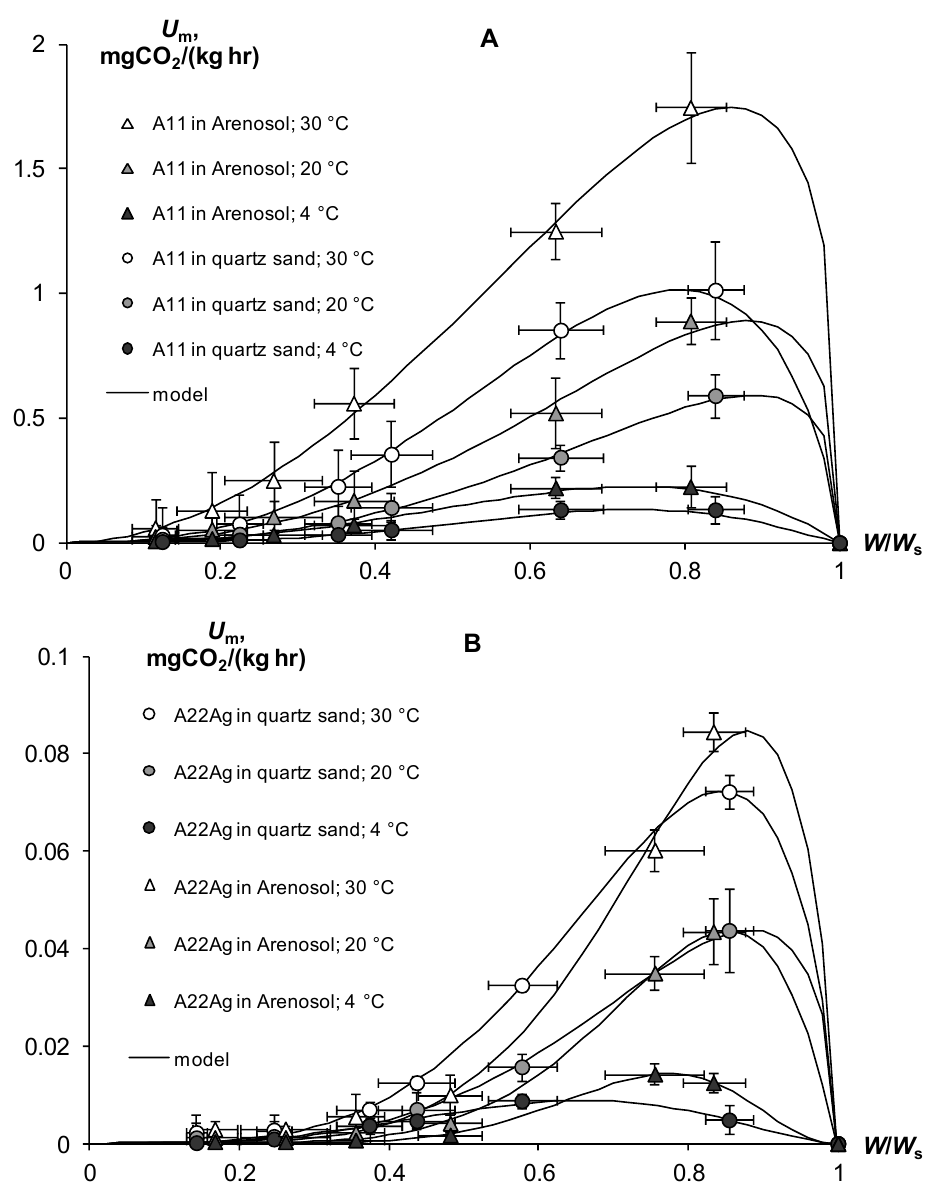
Figure 13. Quantification and modeling of basal respiration of soil-gel compositions ( U m ) as a function of temperature and relative water content ( W/W s ). ( A ) — A11; ( B ) — A22Ag. Model (28) parameters: A11 in Arenosol: 30 °C, f (W) = ( W/W s / 0.86) 2.05 {(1 − W/W s ) / (1 − 0.86)} 0.33 ; R 2 = 0.998, s = 0.02; 20 °C, f (W) = ( W/W s / 0.88) 2.59 {(1 − W/W s ) / (1 − 0.88)} 0.35 ; R 2 = 0.992, s = 0.04; 4 °C, f (W) = ( W/W s / 0.74) 2.84 {(1 − W/W s ) / (1 − 0.74)} 1.00 ; R 2 = 0.992, s = 0.04; A11 in quartz sand: 30 °C, f (W) = ( W/W s / 0.79) 2.77 {(1 − W/W s ) / (1 − 0.79)} 0.72 ; R 2 = 0.997, s = 0.02; 20 °C, f (W) = ( W/W s / 0.89) 2.77 {(1 − W/W s ) / (1 − 0.89)} 0.35 ; R 2 = 0.997, s = 0.02; 4 °C, f (W) = ( W/W s / 0.73) 3.52 {(1 − W/W s ) / (1 − 0.73)} 1.27 ; R 2 = 0.988, s = 0.05; A22Ag in Arenosol: 30 °C, f (W) = ( W/W s / 0.88) 5.30 {(1 − W/W s ) / (1 − 0.88)} 0.72 ; R 2 = 0.993, s = 0.04; 20 °C, f (W) = ( W/W s / 0.85) 6.27 {(1 − W/W s ) / (1 − 0.85)} 1.08 ; R 2 = 0.997, s = 0.02; 4 °C, f (W) = ( W/W s / 0.77) 8.69 {(1 − W/W s ) / (1 − 0.77)} 2.54 ; R 2 = 0.998, s = 0.02; A22Ag in quartz sand: 30 °C, f (W) = ( W/W s / 0.75) 4.04 {(1 − W/W s ) / (1 − 0.75)} 0.73 ; R 2 = 0.999, s = 0.01; 20 °C, f (W) = ( W/W s / 0.88) 3.86 {(1 − W/W s ) / (1 − 0.88)} 0.51 ; R 2 = 0.998, s = 0.02; 4 °C, f (W) = ( W/W s / 0.66) 3.54 {(1 − W/W s ) / (1 − 0.66)} 1.81 ; R 2 = 0.988, s = 0.04.